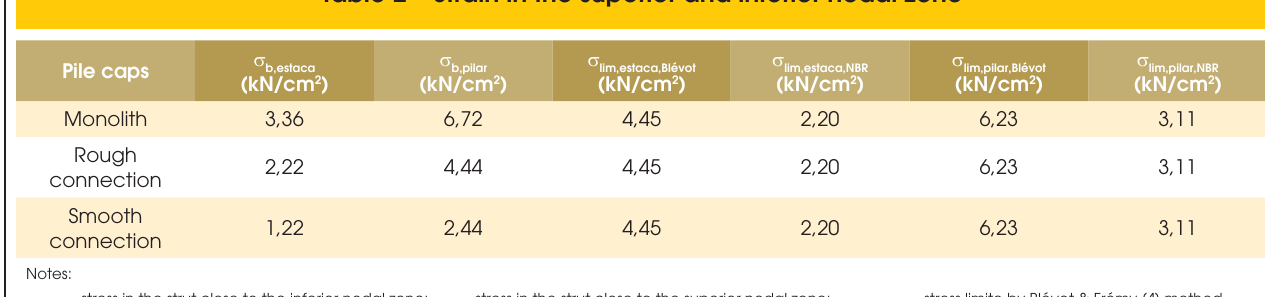
Table 2 – Strain in the superior and inferior nodal zone